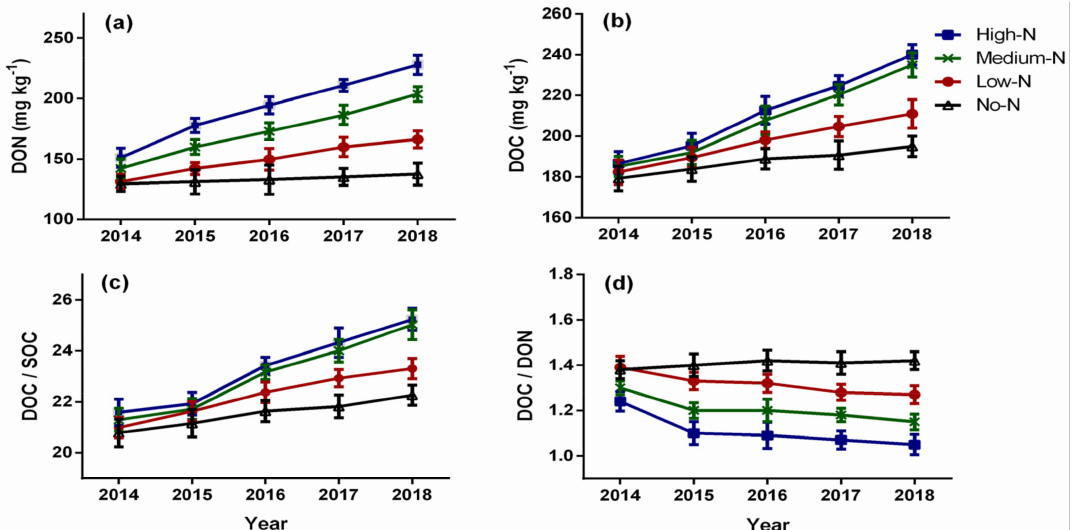
Figure 4. Effects of nitrogen enrichment on dissolved organic nitrogen ( a ), dissolved organic carbon ( b ), dissolved organic carbon and soil organic carbon ratio ( c ), dissolved organic nitrogen and dissolved organic nitrogen ratio ( d ). DON = dissolved organic nitrogen; DOC = dissolved organic carbon; SOC = soil organic carbon. Bars represent ± standard error of means, with four